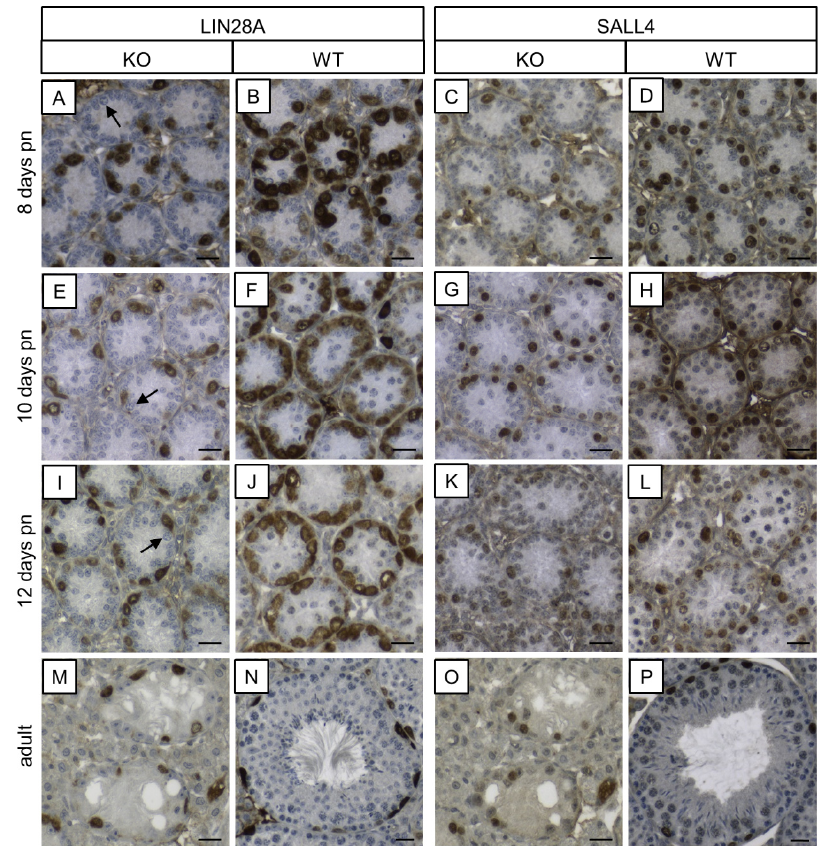
Figure 10. Immunohistochemical detection of LIN28A and SALL4 in SCCx43KO and WT mice. ( A,E,I ) In seminiferous tubules of prepubertal KO mice, almost all spermatogonia are immunopositive for LIN28A, except for a few single ones (arrows). ( M ) In adult KO mice, seminiferous tubules show a spermatogenic arrest at the spermatogonial level. LIN28A immunolabeling is observable in remaining spermatogonia. ( B,F,J,N ) Seminiferous tubules of WT mice at di ff erent ages show an immunostaining according to the age. ( C,G,K,O ) In prepubertal and adult KO mice, spermatogonia are immunopositive for SALL4. ( D,H,L,P ) SALL4 immunoreactivity is detectable in spermatogonia in a typical pattern according to the age in the prepubertal and adult WT mice. KO: knockout, pn: post-natum, SCCx43KO: Sertoli cell-specific Cx43 knockout, WT: wild type, scale bars: 20 µ m, numerical aperture: